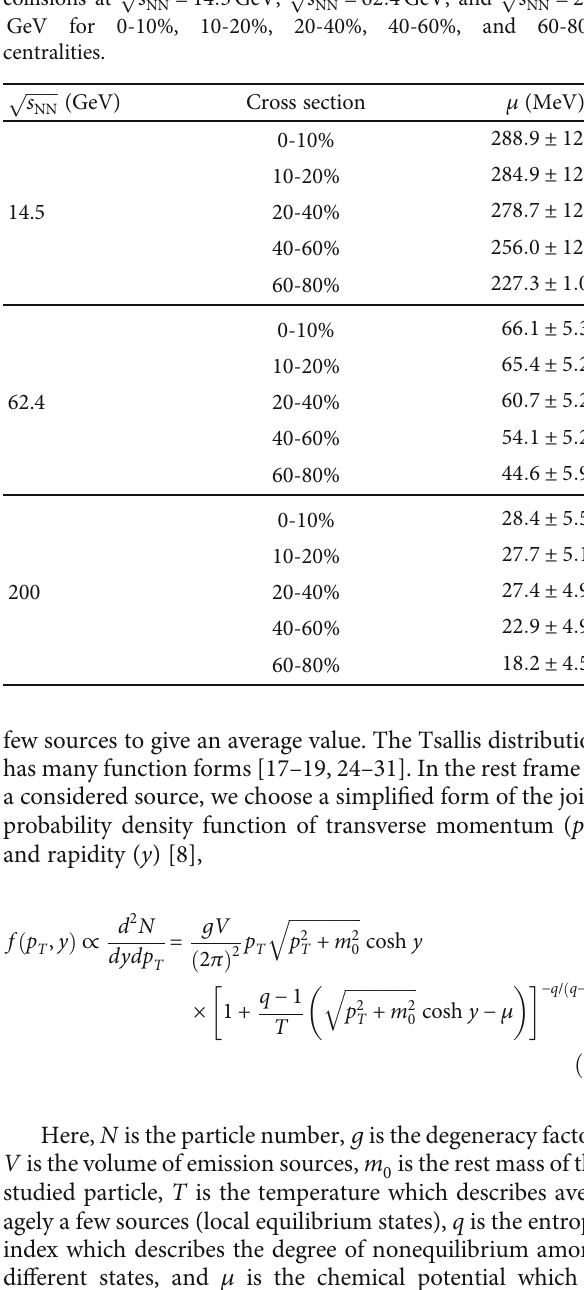
Table 1: Values of μ corresponding to the curves in Au+Au ffiffiffiffiffiffiffi collisions at s NN